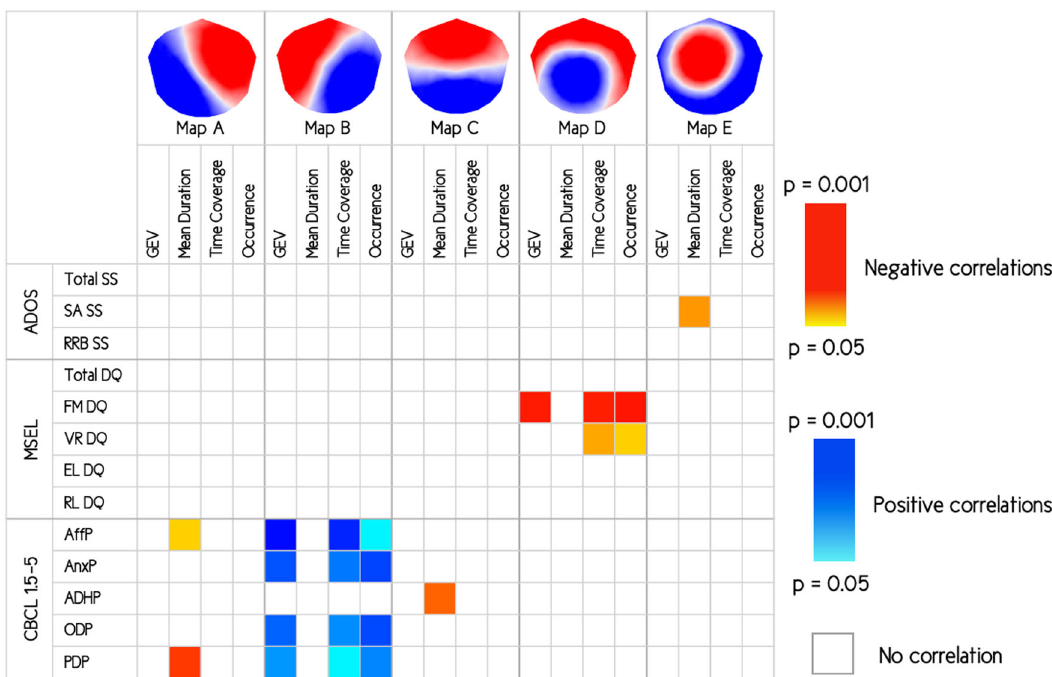
Fig. 4 Correlations with clinical measures. Matrix of exploratory correlations with clinical measures within autism spectrum disorders (ASD) group. Uncorrected p -values. ADOS = Autism Diagnostic Observation Schedule; SS = severity score; SA = social affect; RRB = repetitive and restricted behaviors; MSEL = Mullen Scales of Early Learning; DQ = developmental quotient; FM = fi ne motor; VR = visual reception; EL = expressive language; RL = receptive language; CBCL = Child Behavior Checklist; AffP = affective problems; AnxP = anxiety problems; ADHP = attention de fi cit/hyperactivity problems; ODP = oppositional de fi ant problems; PDP = pervasive developmental problems.